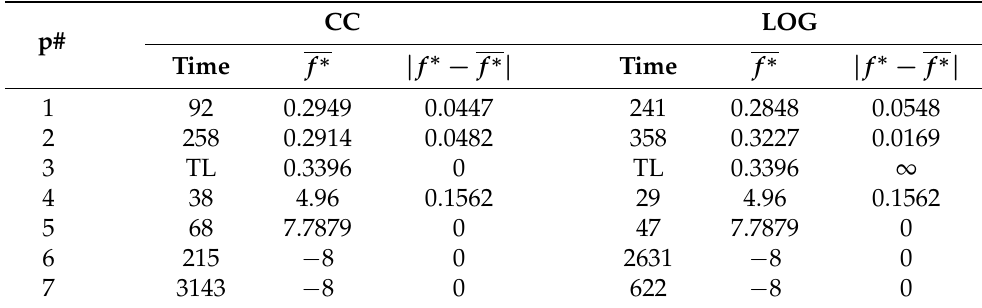
Table 7. Computational Results of Problems Produced by Partial PLA Using 10